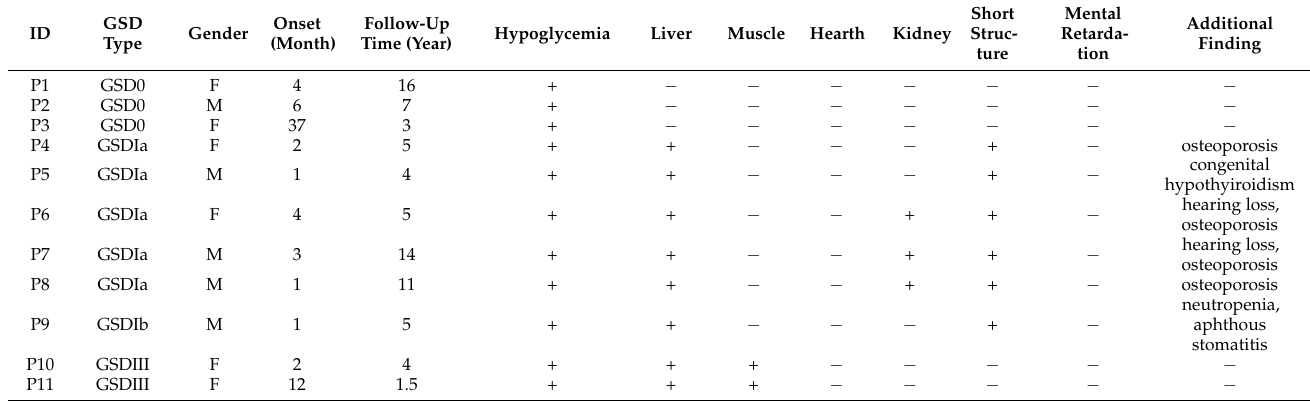
Table 1. Demographic and clinical findings of the